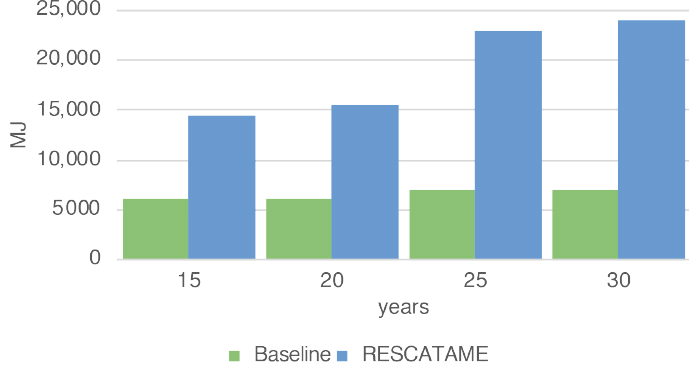
Figure 5. Energy impact comparison of the two solutions in four lifespan scenarios.